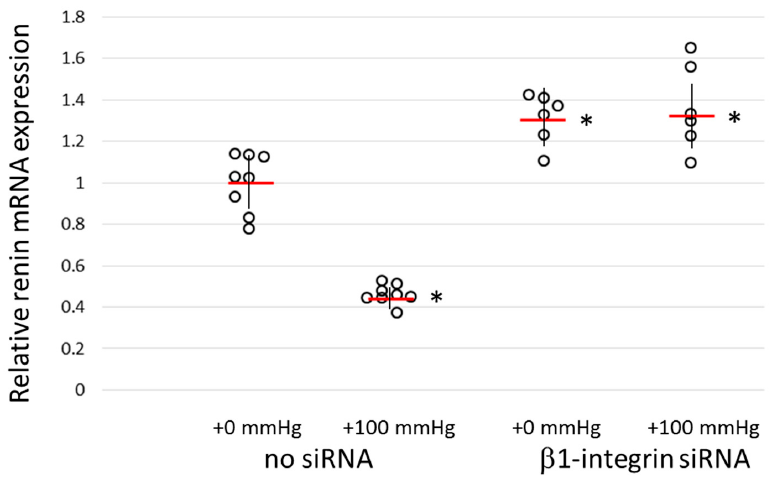
Figure 3. Effect of air pressurization on the renin expression in a juxtaglomerular cell line (As4.1 cells). As4.1 cells were cultured under atmospheric pressure +100 mmHg for 24 h and the renin expression was examined by qRT-PCR (+100 mmHg). Control cells were cultured under normal atmospheric pressure (+0 mmHg). Some cultures were pressurized after β 1-integrin knockdown with siRNA ( β 1-integrin siRNA). Data were represented by scatter plot with the average (red bars) and SD (black vertical lines). Asterisks indicate a significant difference ( p < 0.05) from the control (+0 mmHg, no